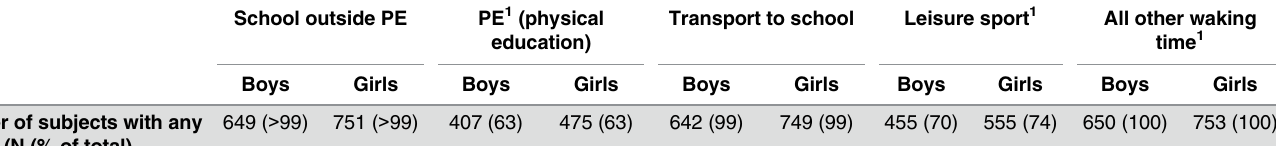
Table 3. Profiles of Activity Domains. Domains profiled only on days when the subject reported the